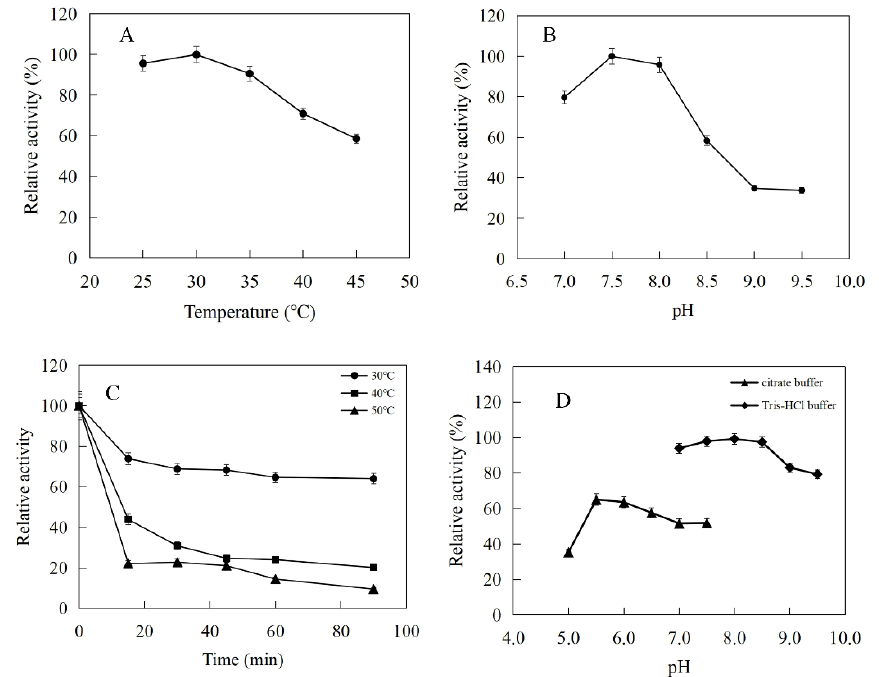
Figure 5. Effects of pH and temperature on the activity and stability of ScPK: ( A ) Effect of temperature on the activity of ScPK. ( B ) Effect of pH on the activity of ScPK. ( C ) Thermostability of ScPK. ( D ) pH stability of ScPK.